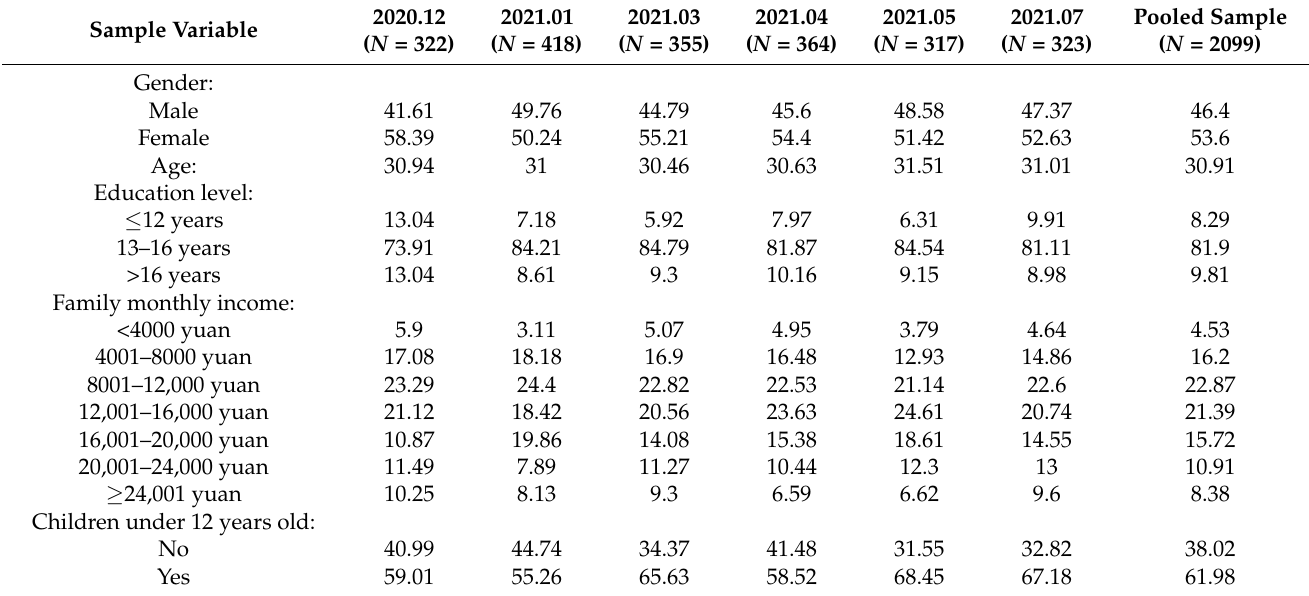
Table 3. Descriptive statistics of six rounds surveys.